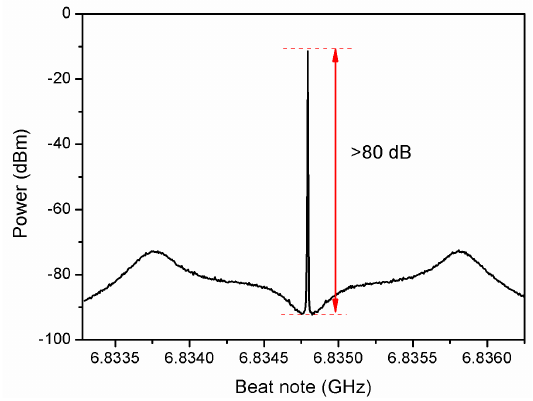
Figure 2. Beatnote between two Raman lasers with a phase noise reduction over 80 dB